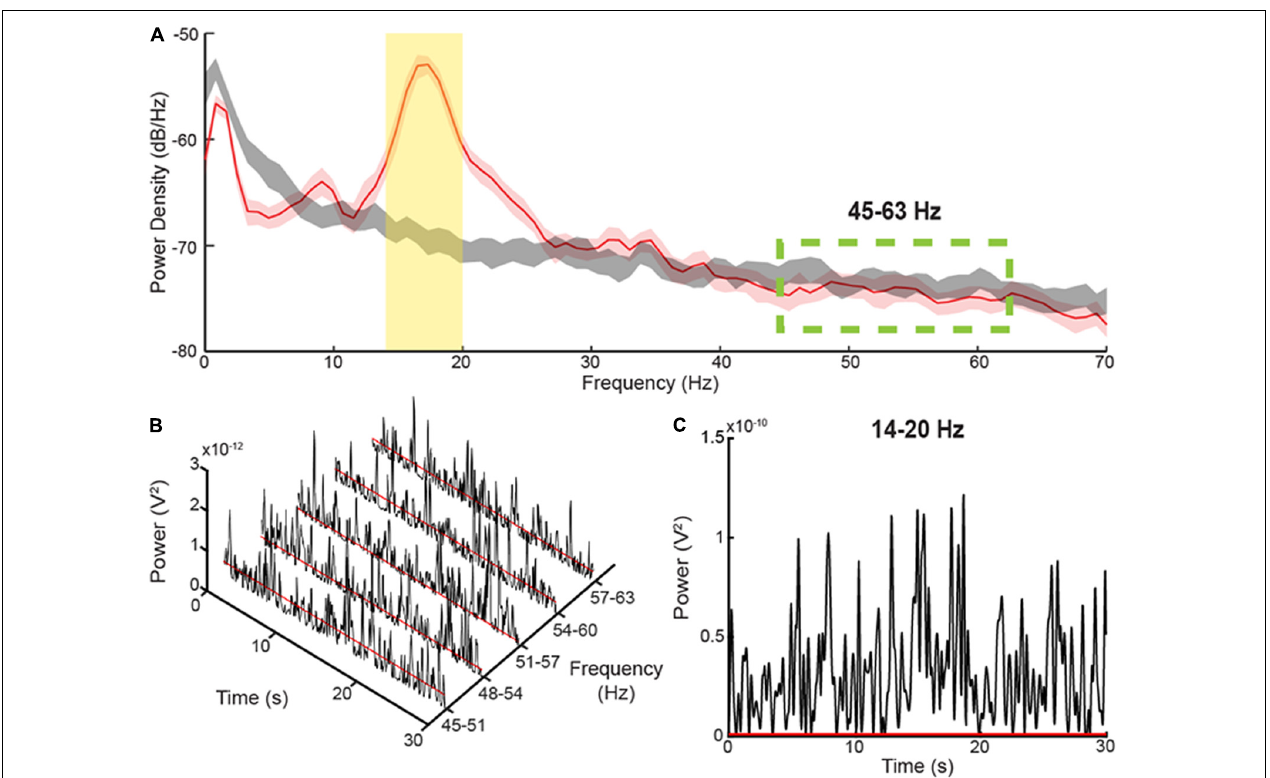
FIGURE 1 | Method for determining burst durations (A) PSD diagrams of 30 s during a Parkinsonian resting state (red) versus pink noise (gray), which can be considered simulated 1/f baseline activity in the brain. The yellow, shaded area represents the 6 Hz band centered on the peak of the PSD. The green-dashed lines display the area where there is no elevation of the resting state PSD above the pink noise simulated 1/f activity. (B) Consecutive, 6 Hz envelopes of the filtered and squared resting state LFP during the resting state within the non-pathological, high frequency range. The red lines signify the median power of the troughs from each envelope. (C) The envelope of a 6 Hz band within the elevated area of the PSD diagram. The threshold for determining burst durations, represented by the red line, was calculated by multiplying the average median trough powers within the high frequency range by a factor of